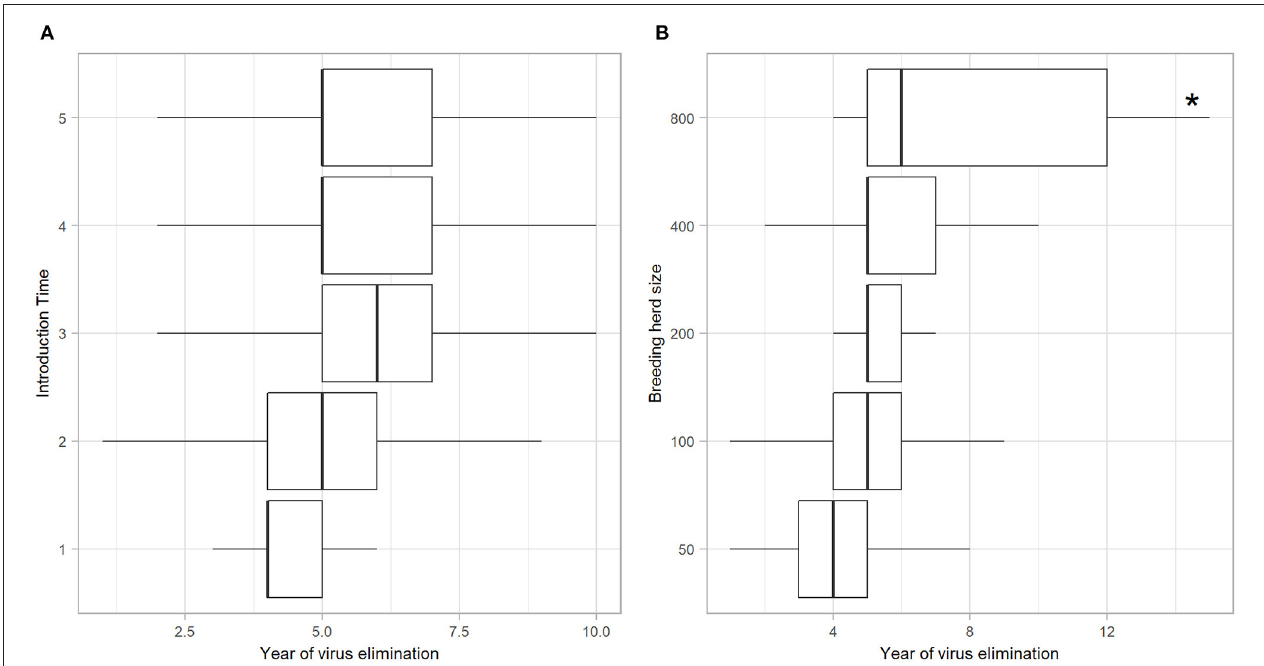
FIGURE 3 | Year of BVDV elimination in those iterations with virus establishment following a single PI introduction in a simulated beef herd. Boxplots illustrating the year at which BVDV self-eliminated from the herd following virus introduction at different times of the production calendar (A) and in different herd sizes (B) . Boxes represent the 25 and 75% percentiles while whiskers represent the 2.5 and 97.5% percentiles. Outliers removed for improved scale and readability. Asterisk (*) indicates that no self-elimination occurred in the 95%